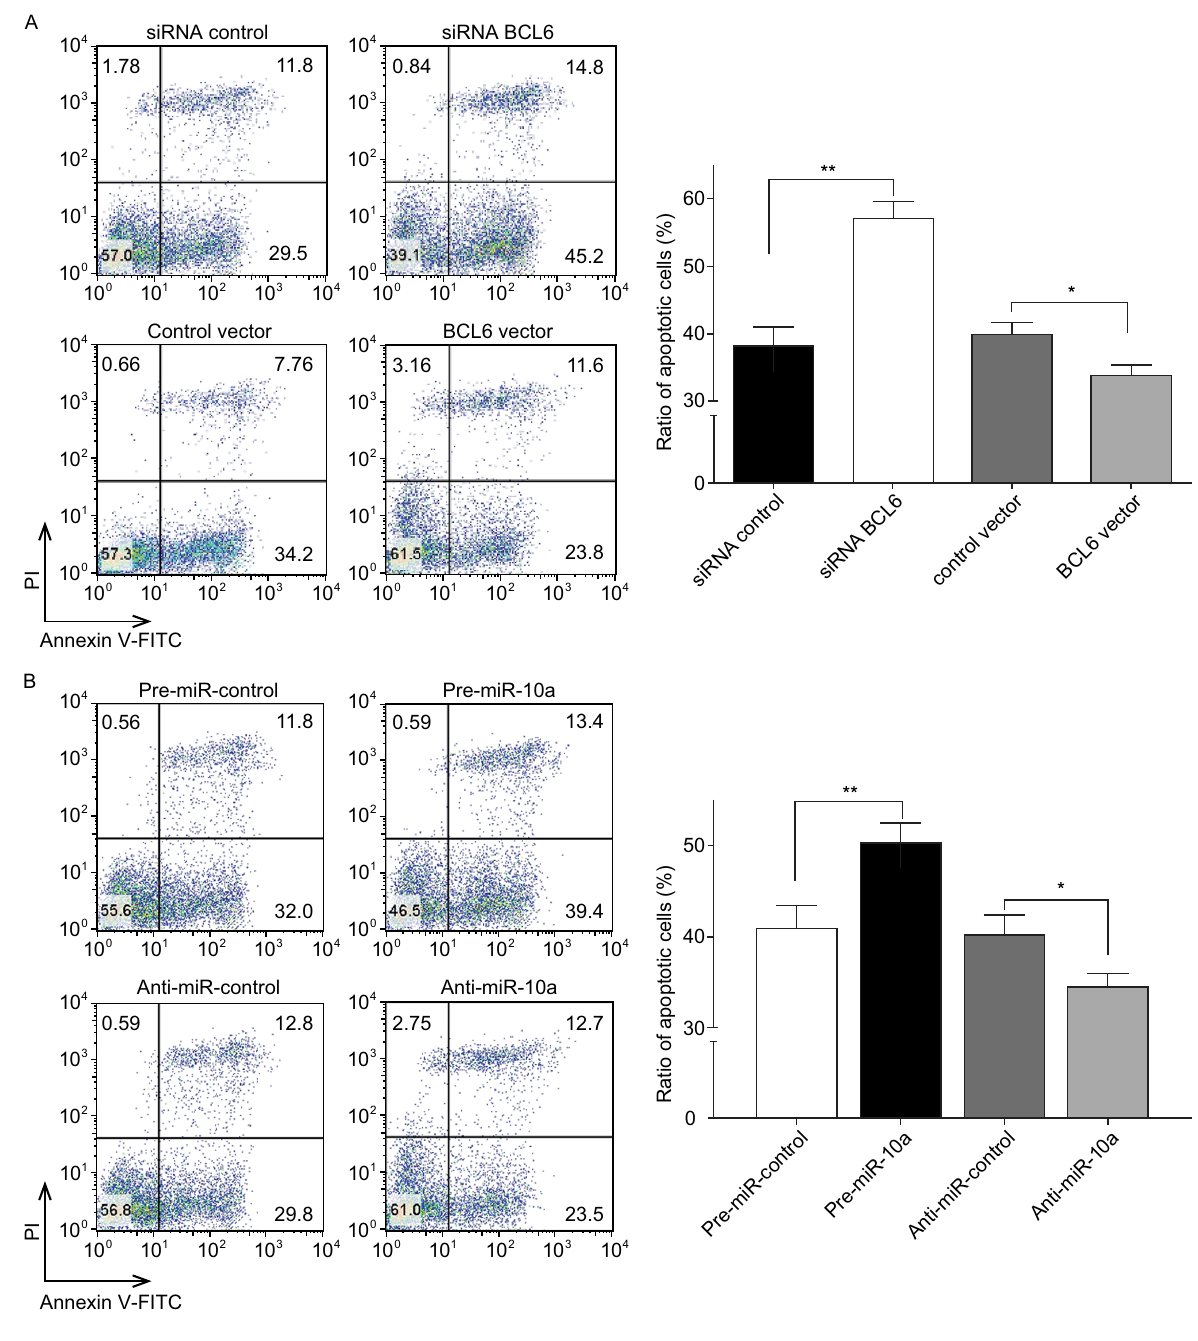
Figure 5. The role of miR-10a targeting BCL6 in the regulation of apoptosis in DLBCL cells. (A)The apoptosis assay was performed 24 h after the transfection of OCI-LY7 cells with equal dose of control siRNA, BCL6 siRNA, control vector or BCL6 overexpression vector; (B) The apoptosis assay was performed 24h after the transfection of OCI-LY7 cells with equal dose of pre- miR-control, pre-miR-10a, anti-miR-control or anti-miR-10a; (C)The apoptosis assay was performed 24h after the transfection of OCI- LY7 cells with pre-miR-control plus control vector, a pre-miR-control plus BCL6 overexpression vector, pre-miR-10a plus control vector, or pre-miR-10a plus BCL6 overexpression vector. Cell apoptosis pro fi les were analyzed by fl ow cytometry. The biparametric histogram shows cells in early (bottom right quadrant) and late apoptotic states (upper right quadrant). Viable cells are double negative (bottom left quadrant). Left panel: representative image; right panel: ratio of apoptotic OCI-LY7 cells. Data are the mean ± SEM of 3 independent experiments performed in triplicate, * P < 0.05; ** P <